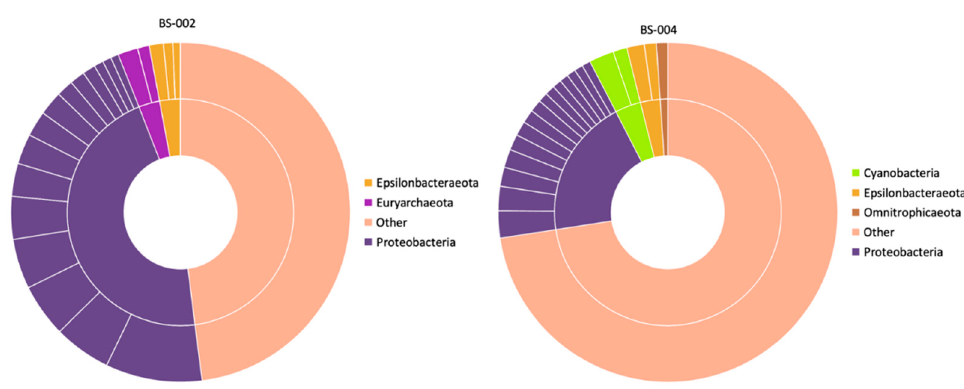
Figure 4. Sunburst chart of top 50% or 20 microorganisms (OTUs) with the highest abundance in the uncontaminated bores (UBs) (BS-002, BS-004) separated by bore and organised by phylum. ‘Other’ represents the proportion of OTUs not represented by the 20 most abundant OTUs. The inner ring of the sunburst chart represents the phylum taxonomic level and the inner ring represents the individual OTUs.